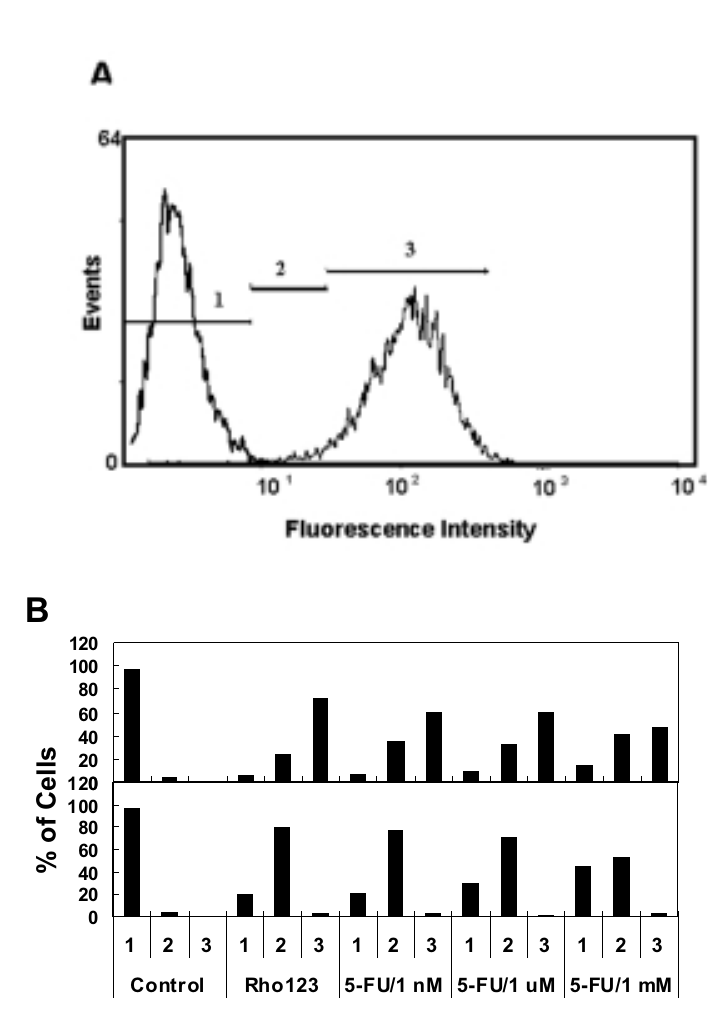
Fig. 5 – Increased extrusion of Rho 123 following 5-fluorouracil treatment. Cells were cultured with 5-fluorouracil (1nM – 1mM) for 72h. After this period cells were washed and incubated with 200 ng/ml Rho 123 for 30 min at 37 ◦ C, washed with cold saline and left to extrude the dye for a further 30 min. The cells were then washed and analysed in a flow cytometer. A – Fluorescence profile of K562 cells exposed to Rho 123; region 1 represents autofluorescence of cells not exposed to Rho 123, region 3 represents the region containing the fluorescence peak of these cells exposed to Rho 123 and region 2 corresponds to the area in between. B – Upper panel: K562 cells; Lower panel: Lucena 1 cells. Region 1 represents autofluorescence in control cells, region 2 the peak of fluorescence of Lucena 1 cells and region 3 the peak of fluorescence of K562